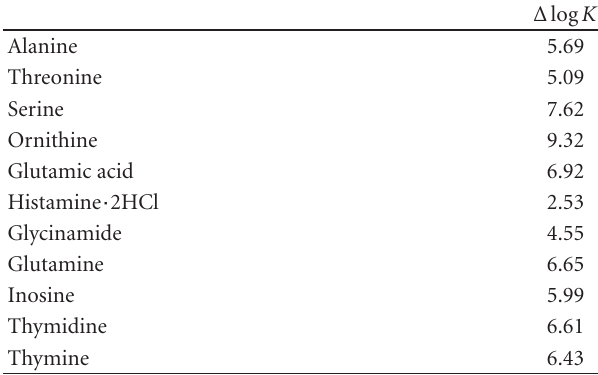
Figure 7: Concentration distribution of various species as a func- tion of pH in the [Zn(BAPP)(threonine)] system (1.25mM of Zn 2+ , BAPP, and threonine).